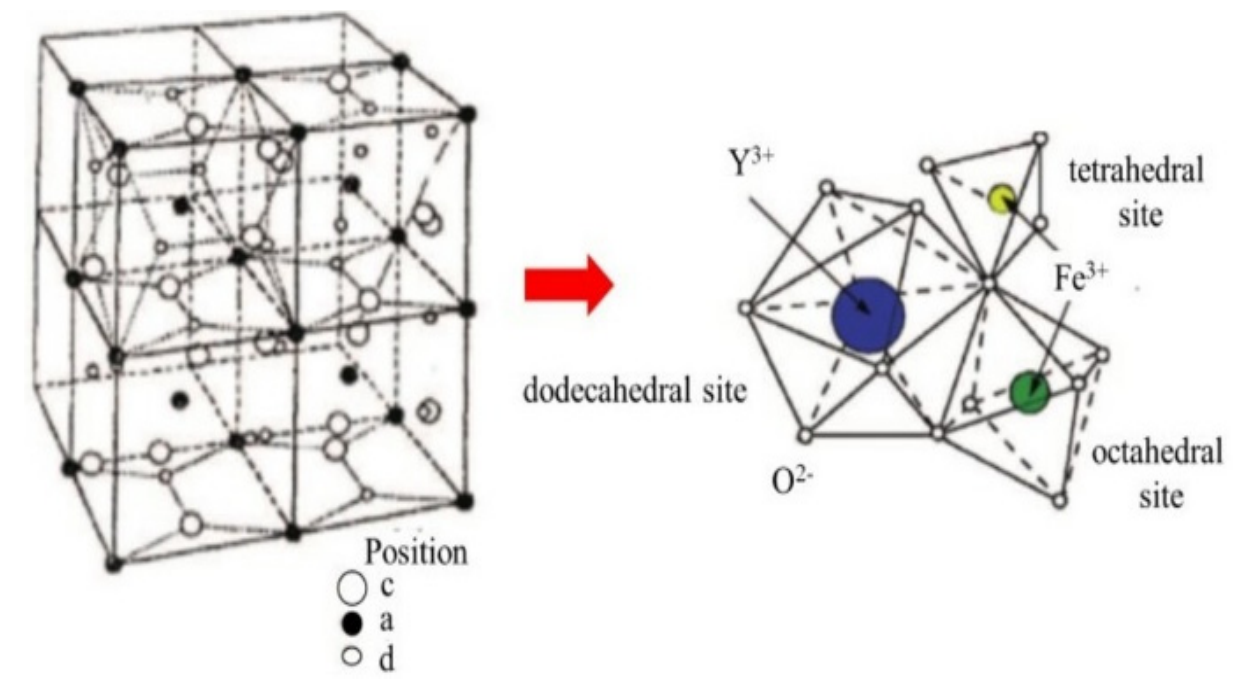
Figure 2. Unit cell YIG with three cation sub-lattices [67]. Table 1. The top 100 papers in the field of yttrium iron garnet, ranked from highest to lowest by number using the Scopus